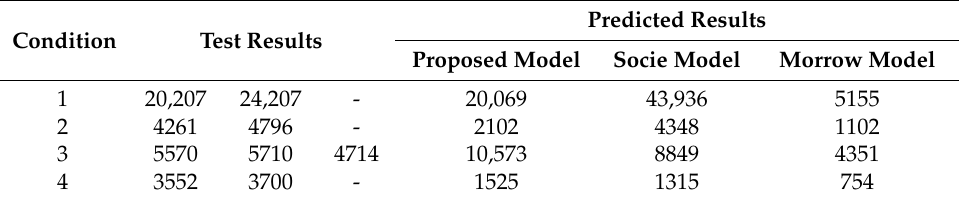
Table 9. Comparison of predicted life and experimental life for all